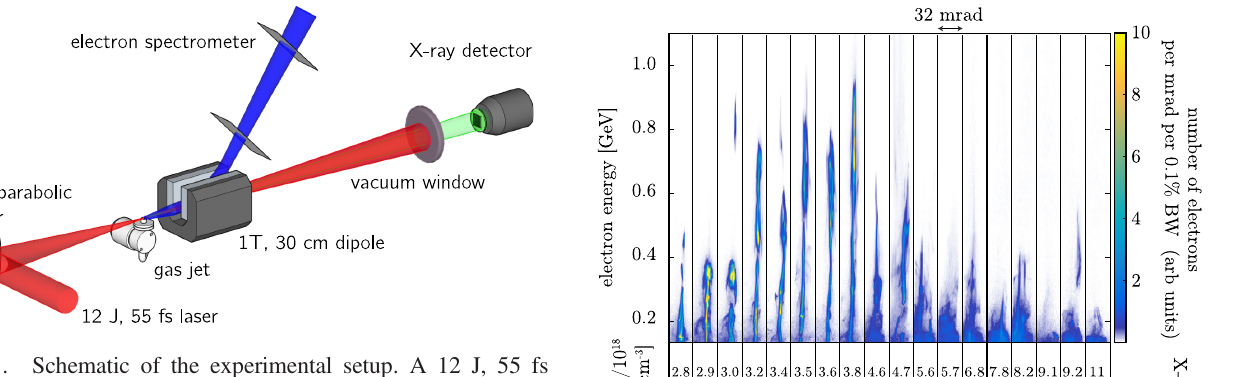
FIG. 1. Schematic of the experimental setup. A 12 J, 55 fs laser pulse is focused by an f= 20 parabolic mirror onto a gas jet target which produces a centimeter-scale plasma with densities ∼ 10 19 cm − 3 . Giga-electron-volt-scale electrons produced in the interaction are deflected by a dipole magnet onto two scintillating screens to measure the energy spectrum. Kilo-electron-volt x rays pass out of the vacuum chamber through a thin window and are detected by an indirect-detection x-ray CCD camera. An array of metallic filters in front of the CCD allows properties of the x-ray spectrum to be inferred.